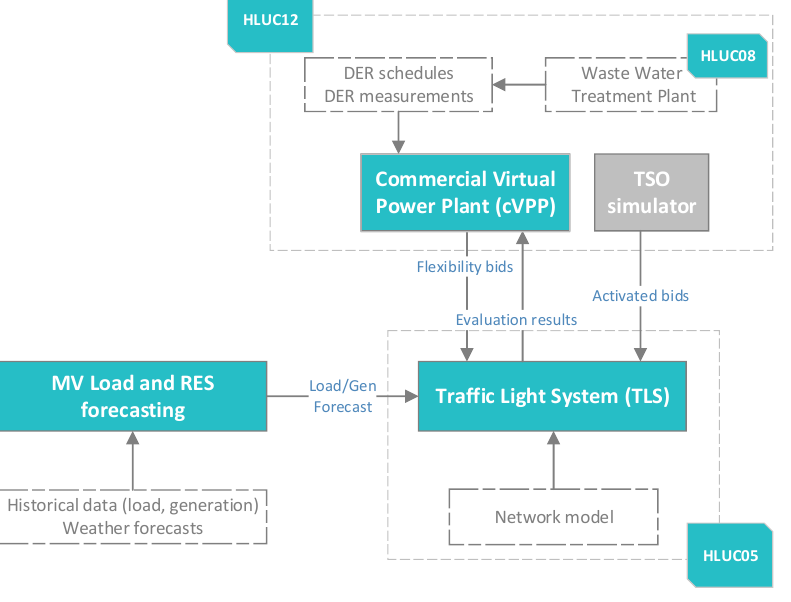
Figure 13. Cluster 03. Global